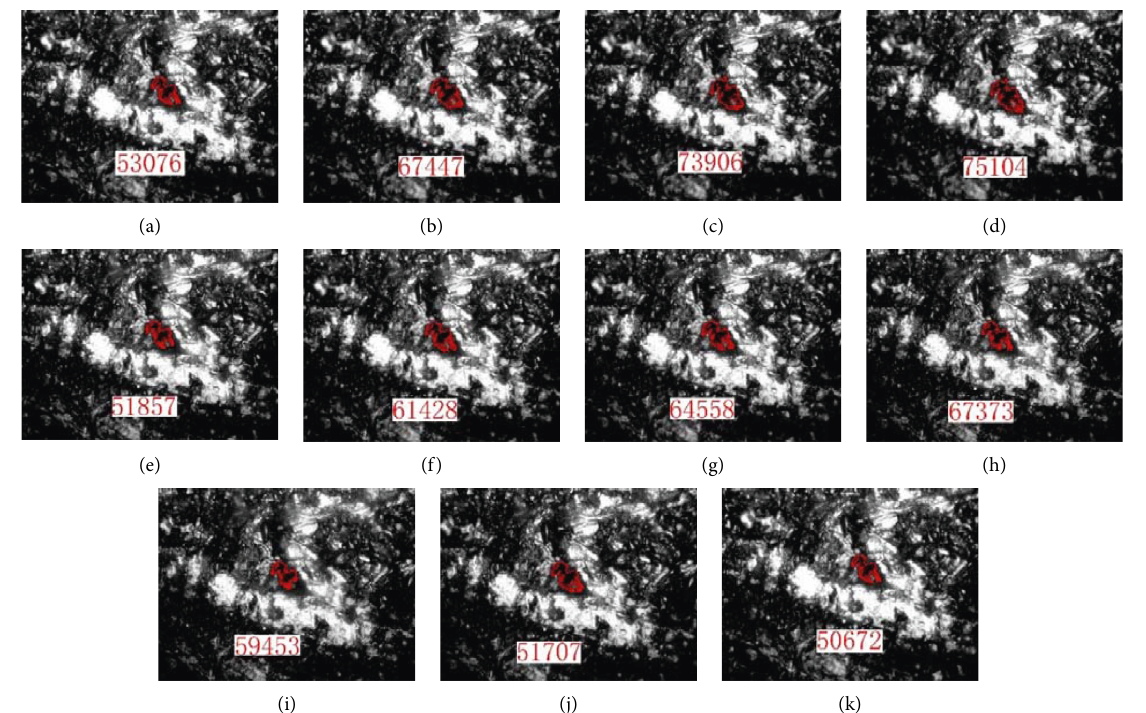
Figure 5: Microimages of coking coal sample identification pore on the increasing temperature. (a) 22 ° C; (b) 60 ° C; (c) 90 ° C; (d) 120 ° C; (e) 150 ° C; (f) 180 ° C; (g) 210 ° C; (h) 240 ° C; (i) 270 ° C; (j) 300 ° C; (k) 350 ° C.